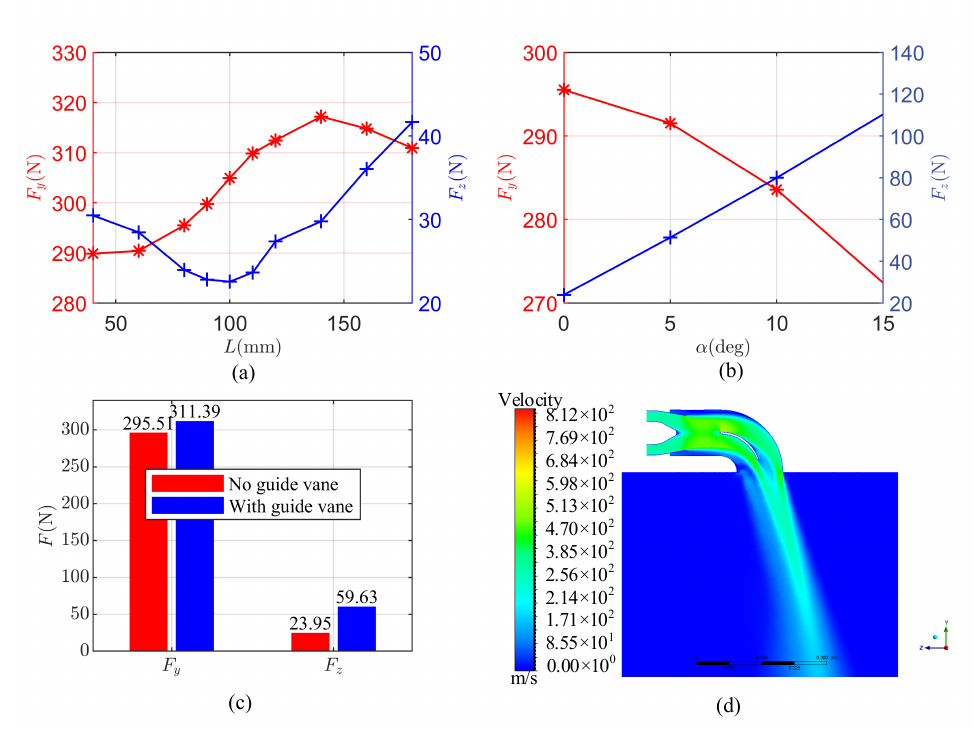
Figure 4. Effects of the nozzle parameters on the thrust in the simulation: ( a ) effect of the length L on the thrust; ( b ) effect of the angle α on the thrust; ( c ) effect of the guide vane on the thrust; ( d ) description of the guide vane’s influence the distribution of air flow.